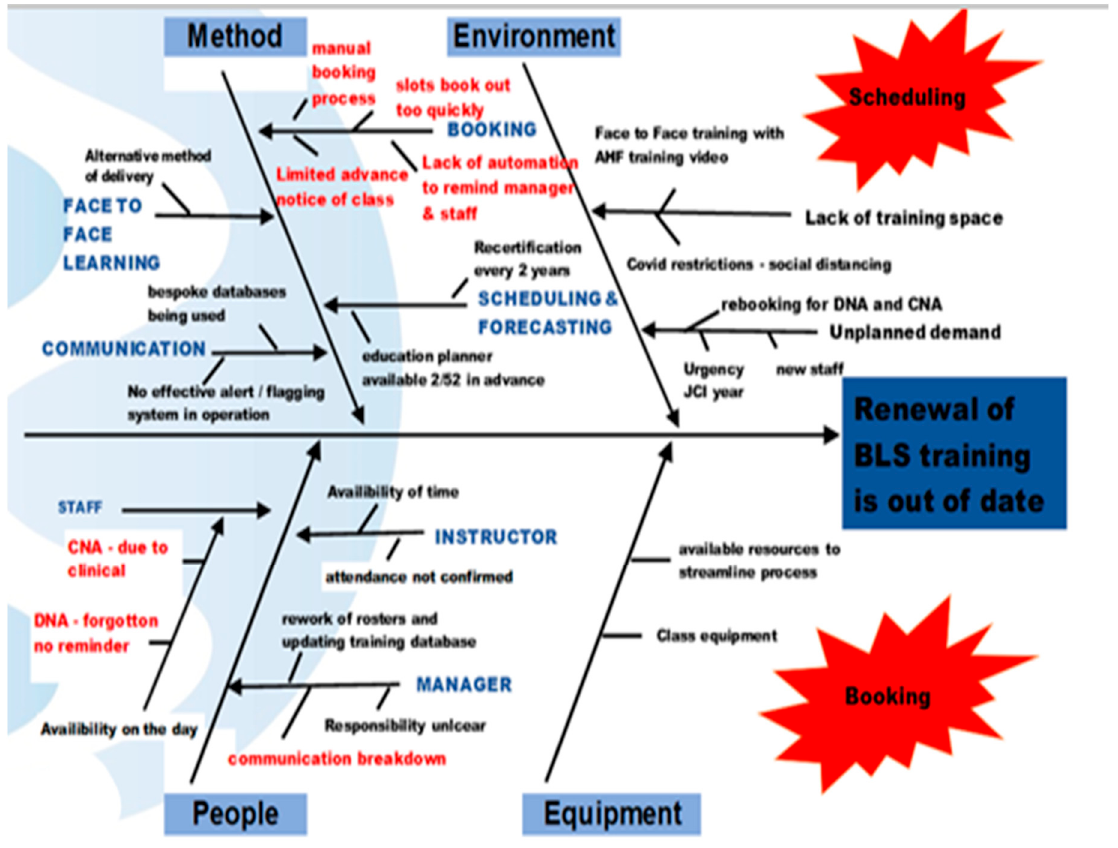
Figure 2. Fishbone Diagram.